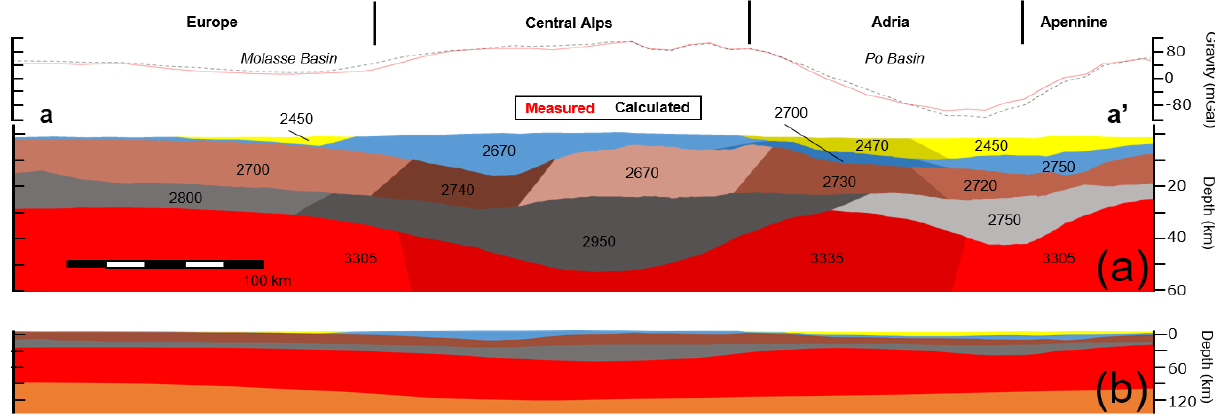
Figure 3. Cross sections through generated model showing thickness of model layers. Location is marked in Figs. 1a, 2, and 4–6 as a–a’. Lithospheric mantle layer is shown in red, lower crust is shown in grey, upper crust is shown in brown, consolidated sediments are shown in blue, and unconsolidated sediments are shown in yellow. In (a) density domains within each layer are shown as a change of shade and the density of each domain is labelled. At the top, the observed and calculated gravity anomalies along the cross section are shown. Panel (b) is scaled to show the thicknesses of all layers down to the asthenospheric mantle, shown in